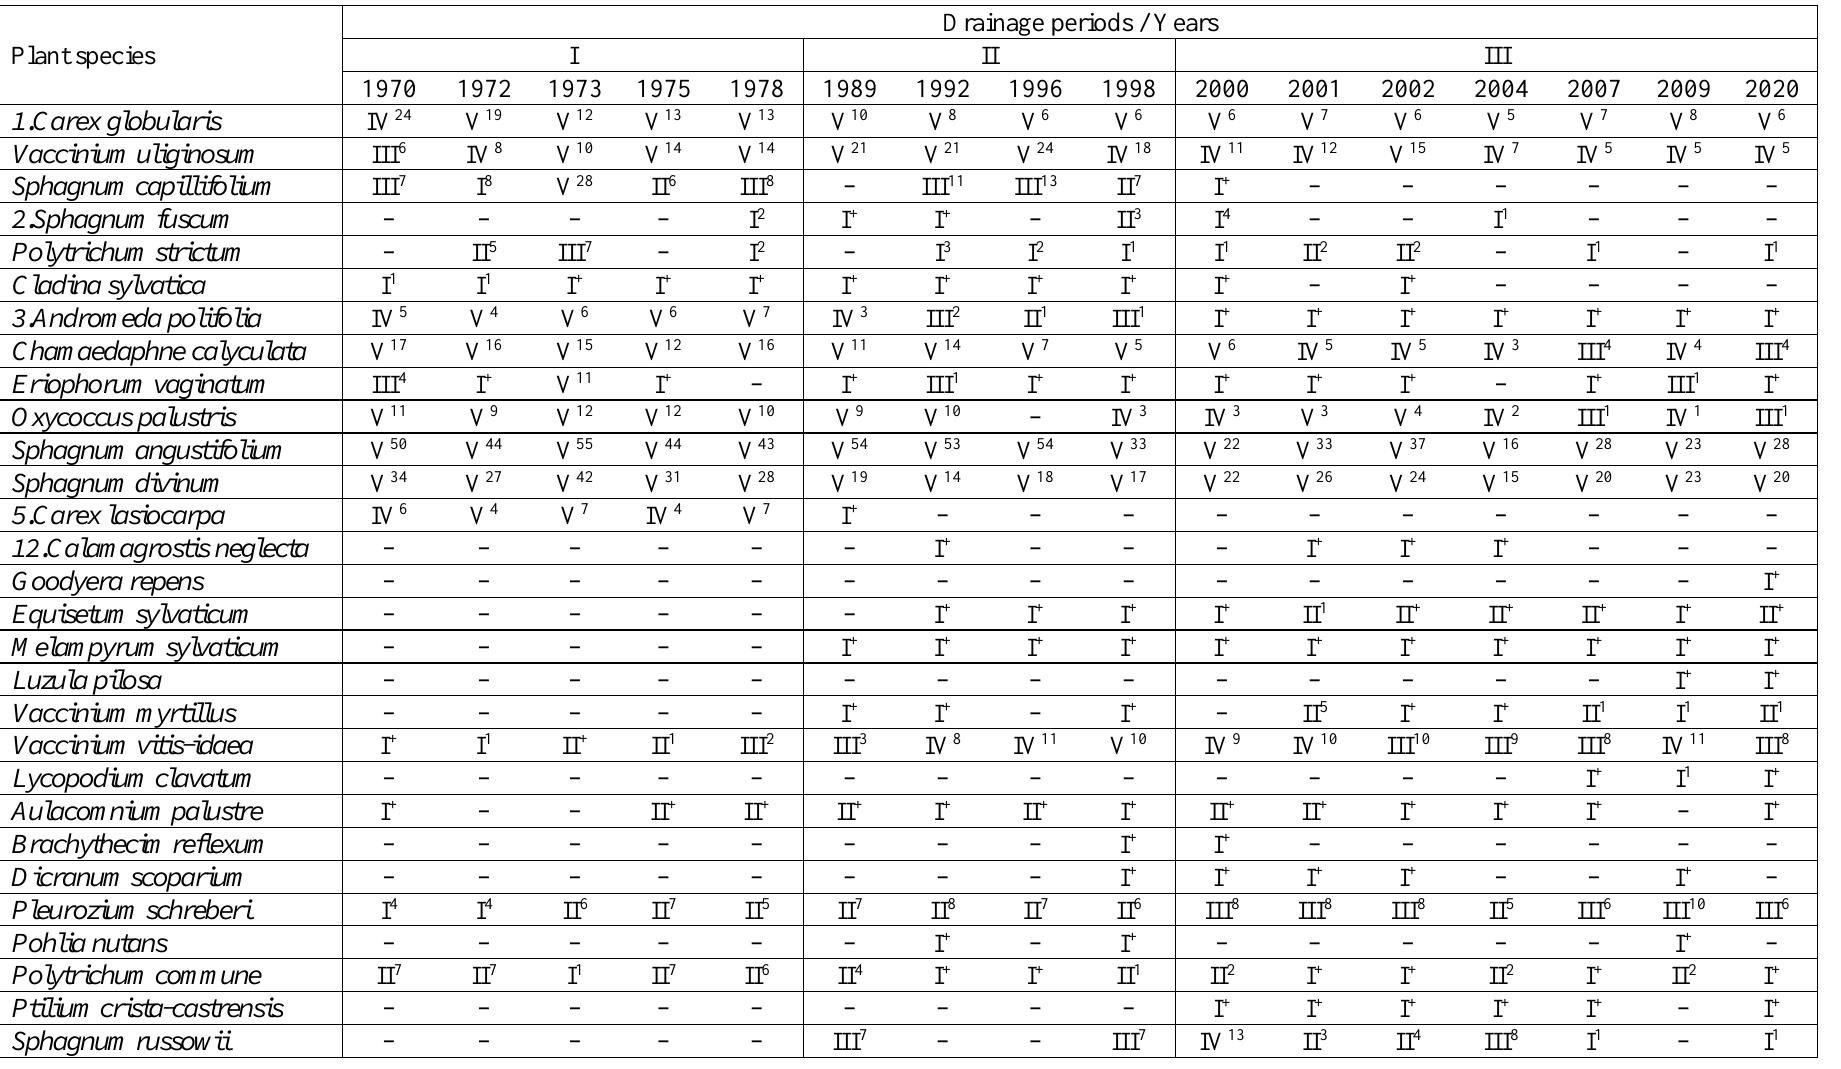
Table 2. Post-drainage changes in species composition of the plant cover at the study site. Numbered plant species correspond to eco-coenotic groups (ECGs). Constancy classes are represented by Roman numerals with mean projective cover (%) as a superscript. Data are shown for representative (not all) years of the study. Plant